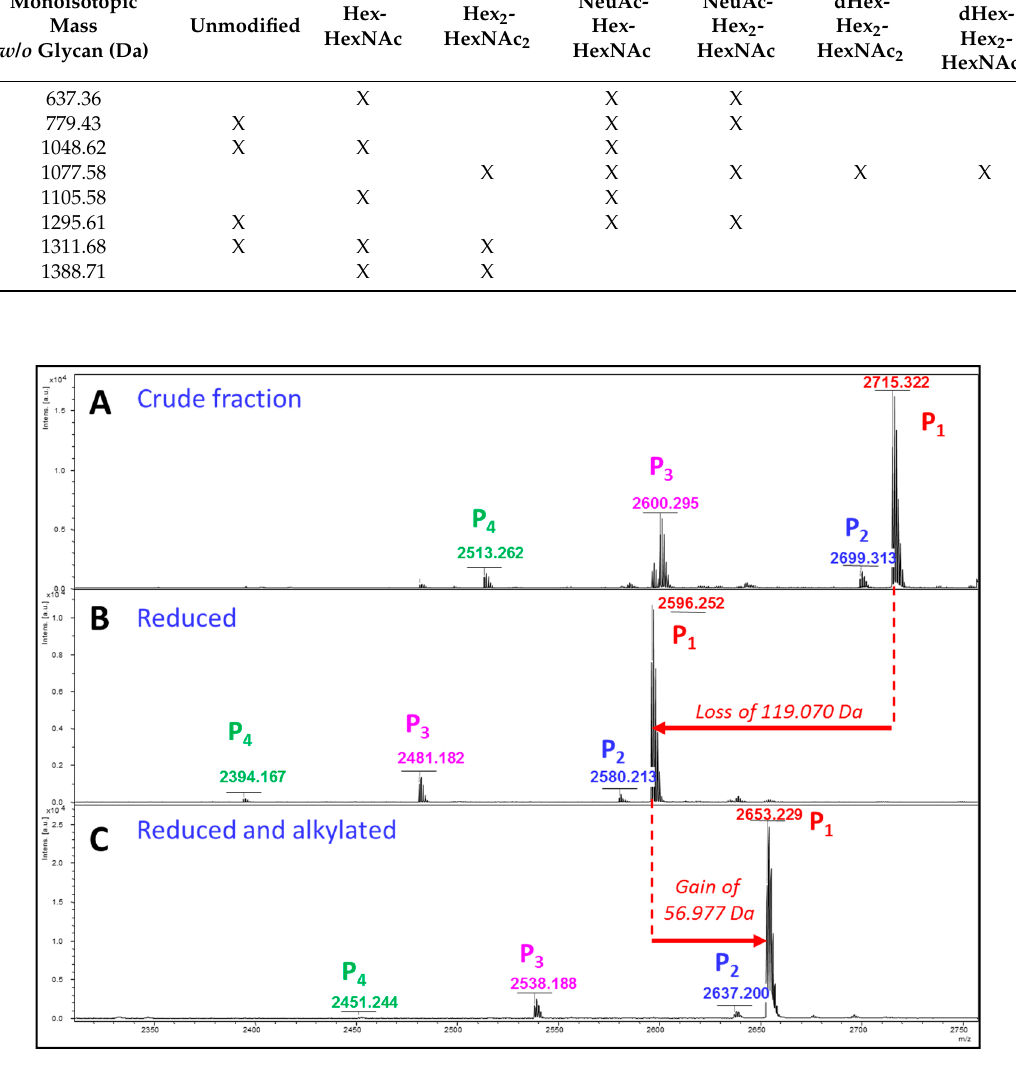
Figure 4. Mass spectra of the S -Cys-GlycoDa-1 fraction in MALDI-MS acquisition. ( A ) crude fraction; ( B ) reduced fraction; and ( C ) reduced and alkylated fraction.